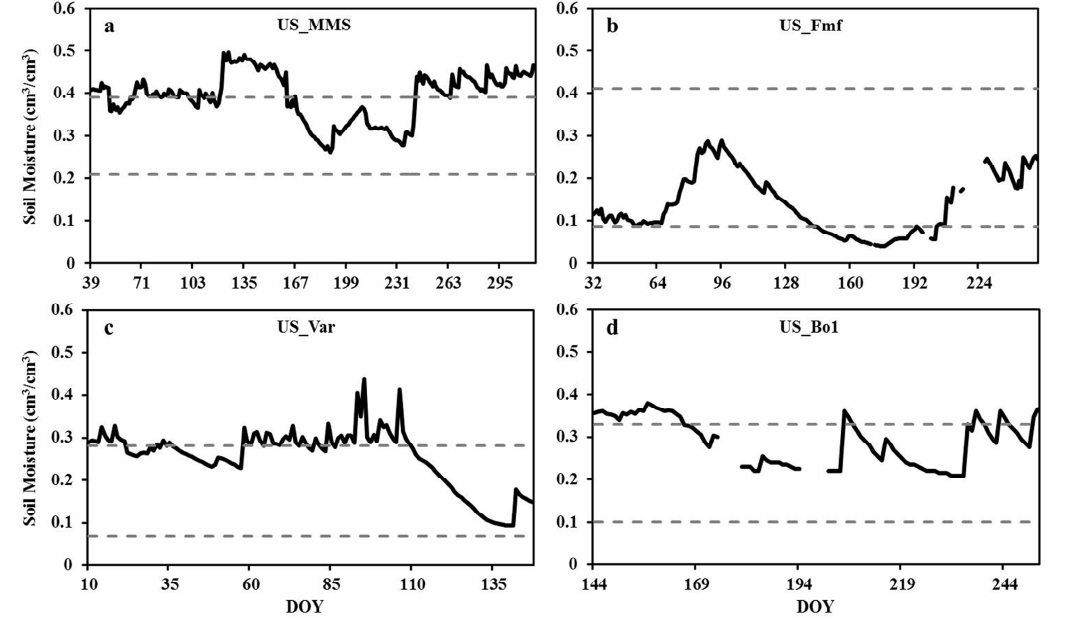
Figure 2. Soil moisture time series at four sites examined in this study (( a ): US_MMS; ( b ): US_Fmf; ( c ): US_Var; and ( d ): US_Bo1). The upper dashed line indicates field capacity and the lower dashed line indicates the wilting